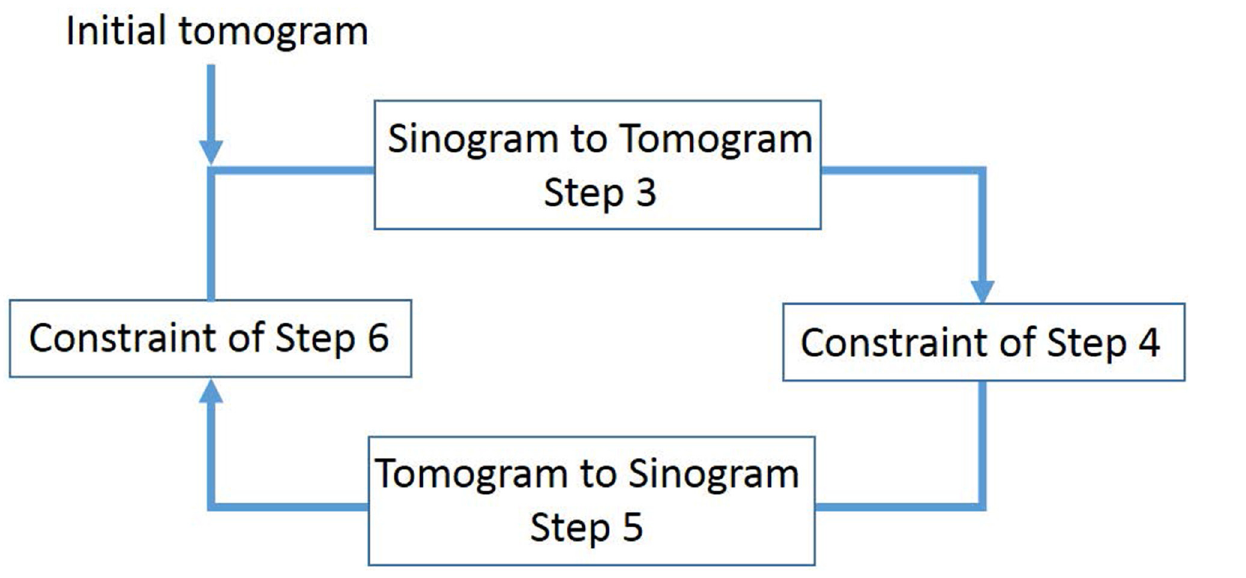
Fig 5. A flowchart of the main computational steps in the artefact reduction